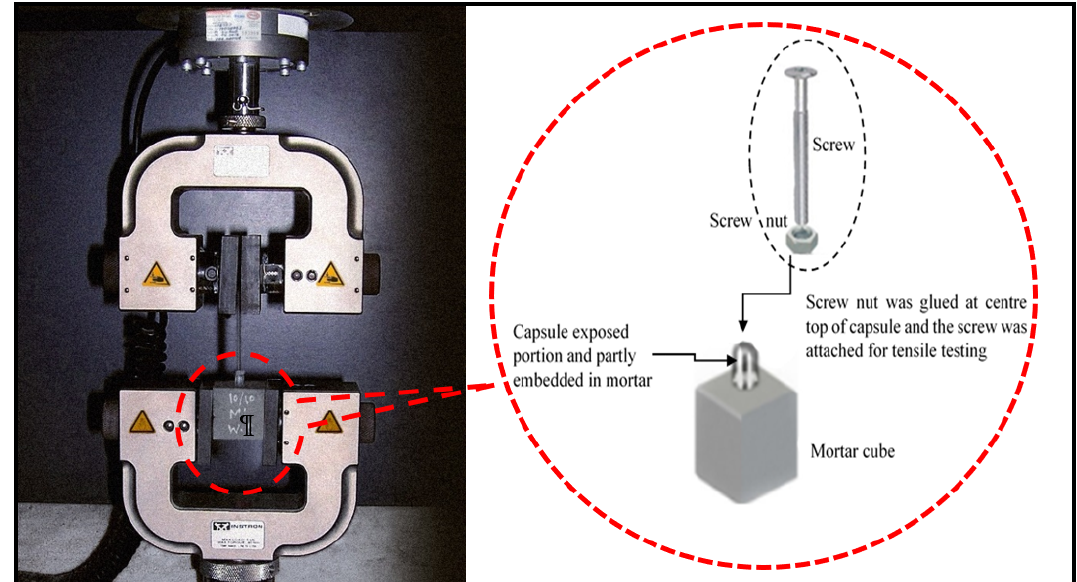
Figure 5. Bonding strength set-up and the schematic diagram of the sample.